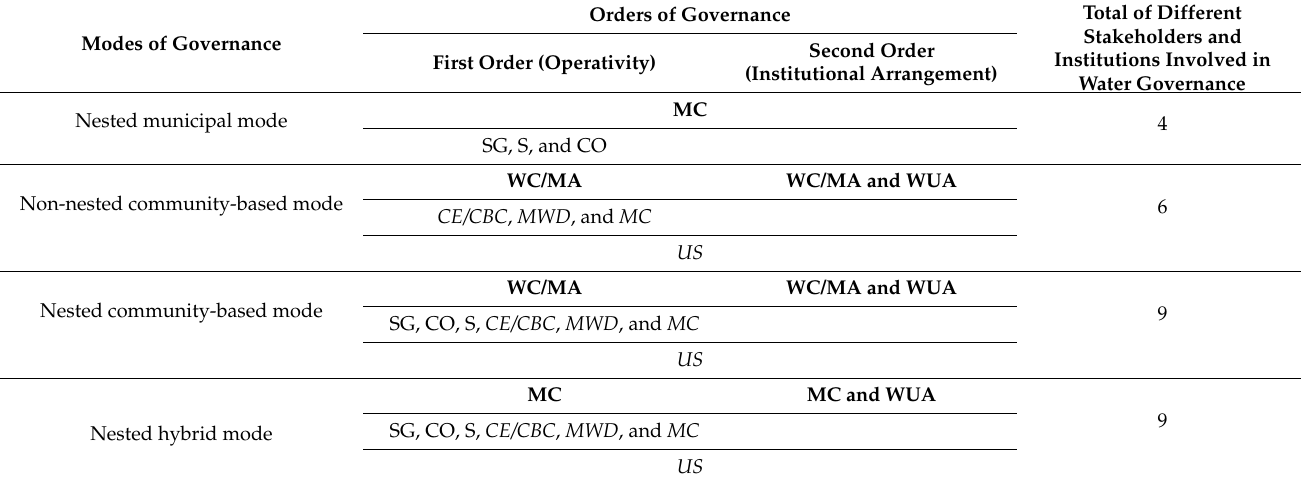
Table 6. Diversity of stakeholders and institutions involved in the first and second orders of governance of the four modes of governance identified at the local level in Oaxaca and possibly in much of Mexico. Bold text indicates the entities responsible for operating and making decisions related to the water supply system for domestic use at the local level. Italic text indicates the stakeholders and institutions belonging to the local jurisdictional level, while Roman text indicates entities belonging to state and national jurisdictional levels. MC = municipal council, WC/MA = water committee/municipal agent, WUA = water users assembly, US = water users, CE/CBC = agrarian council, MWD = Migrant Water Users Directive, SG = State government, CO = National Water Commission, and S = Ministry of Environment and Natural